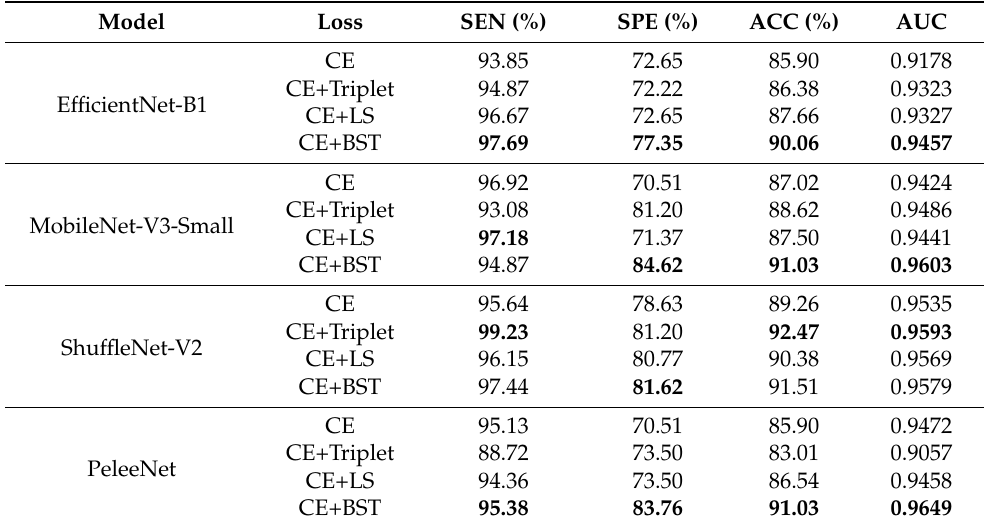
Table 6. Metrics for the compared networks on the Chest-2